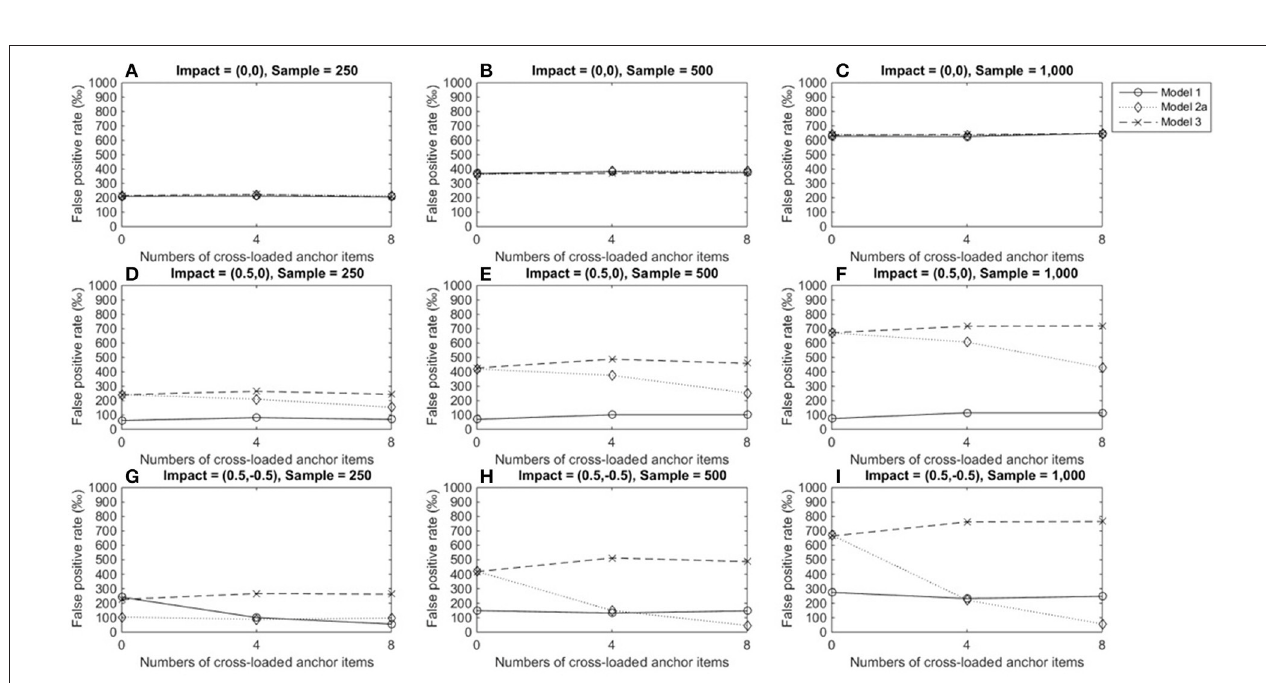
FIGURE 3 | True positive rates when the tested item measured one single domain and DIF magnitude was 0.3. Fore model 1, total scores served as a matching variable; for model 2a, the subset score of domain 1 was used to match participants; model 3 used two subset scores as matching variable. Model 2b was excluded because the tested item did not measure the second domain. (A) Impact = (0,0), Sample = 250; (B) Impact = (0,0), Sample = 500; (C) Impact = (0,0), Sample = 1,000; (D) Impact = (0.5,0), Sample = 250; (E) Impact = (0.5,0), Sample = 500; (F) Impact = (0.5,0), Sample = 1,000; (G) Impact = (0.5, − 0.5), Sample = 250; (H) Impact = (0.5, − 0.5), Sample = 500; (I) Impact = (0.5, − 0.5), Sample = 1,000.